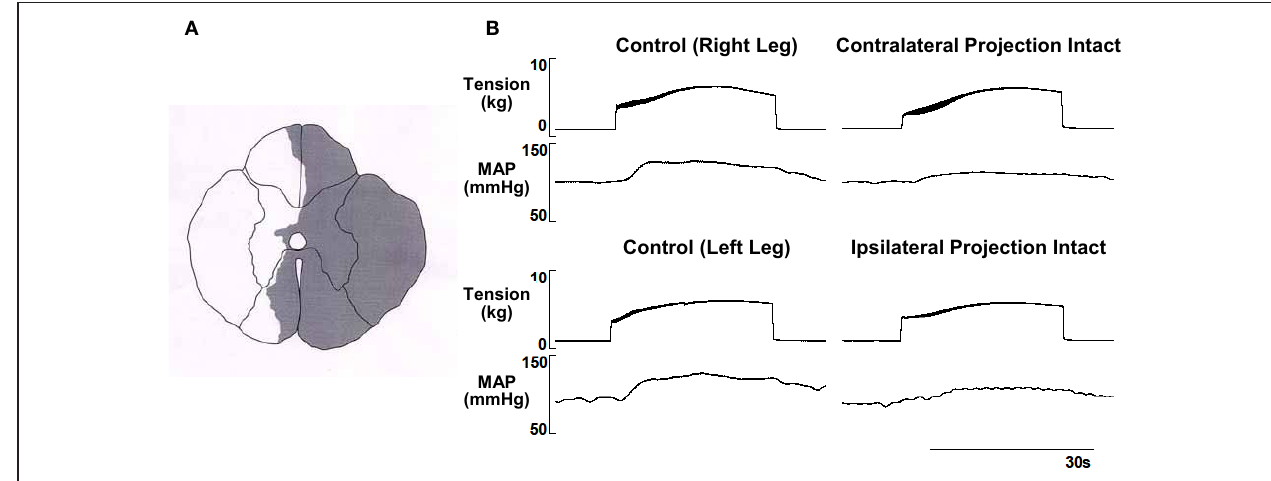
FIGURE 1 | (A) Histological reconstruction of the Brown-Séquard like lesion in the lower spinal cord of one animal. (B) Electrically-induced static contraction increased MAP before (left tracing) and after (right tracing)